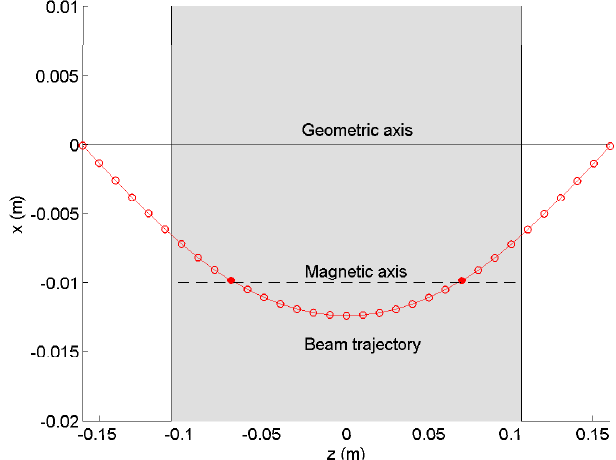
FIG. 14. (Color) Beam trajectory in the central semiperiod as a function of z . The points corresponding to the intersection of the beam trajectory and the new magnetic axis are put in evidence.